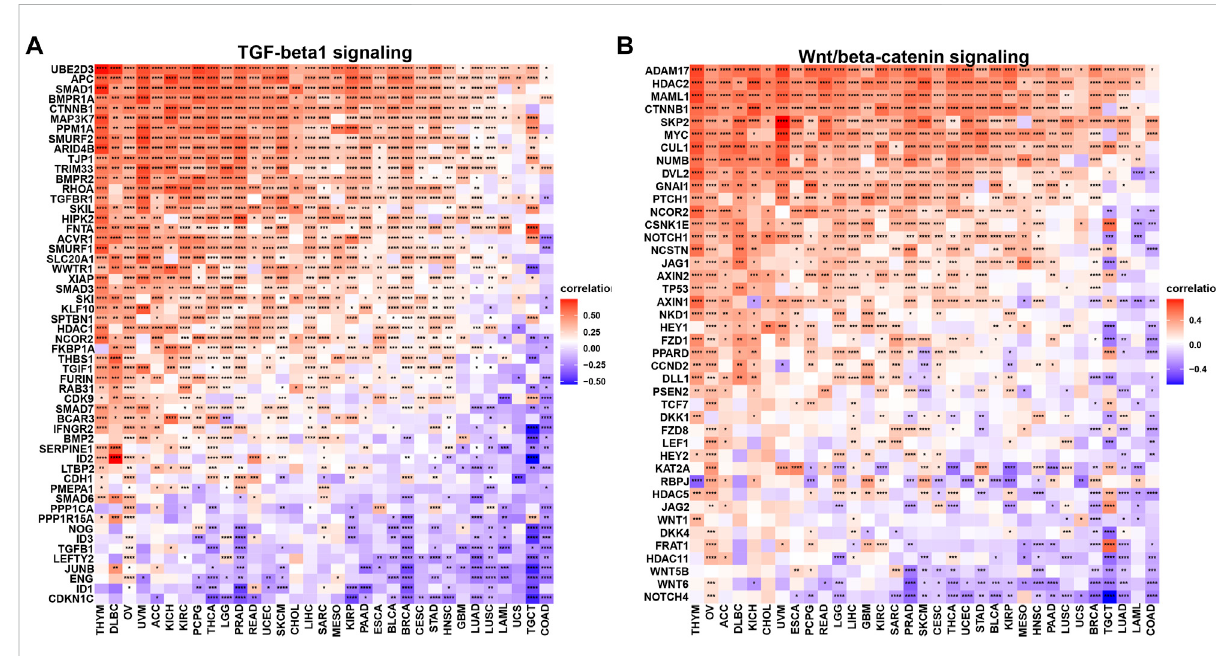
FIGURE 6 Correlation of m7G modi fi cation level and TGF- β 1 and Wnt/ β -catenin signaling pathways. (A) TGF- β 1 signaling pathway. (B) Wnt/ β -catenin signaling